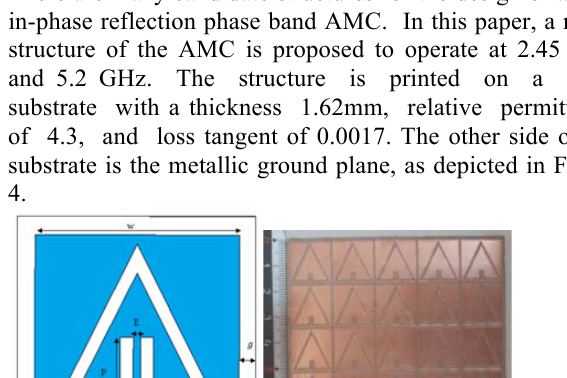
Fig .4. Configuration of the AMC structure under